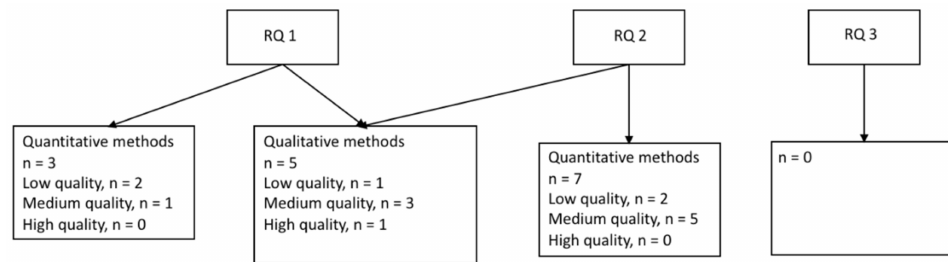
Figure 3. Studies of industries other than healthcare, sorted by research question and